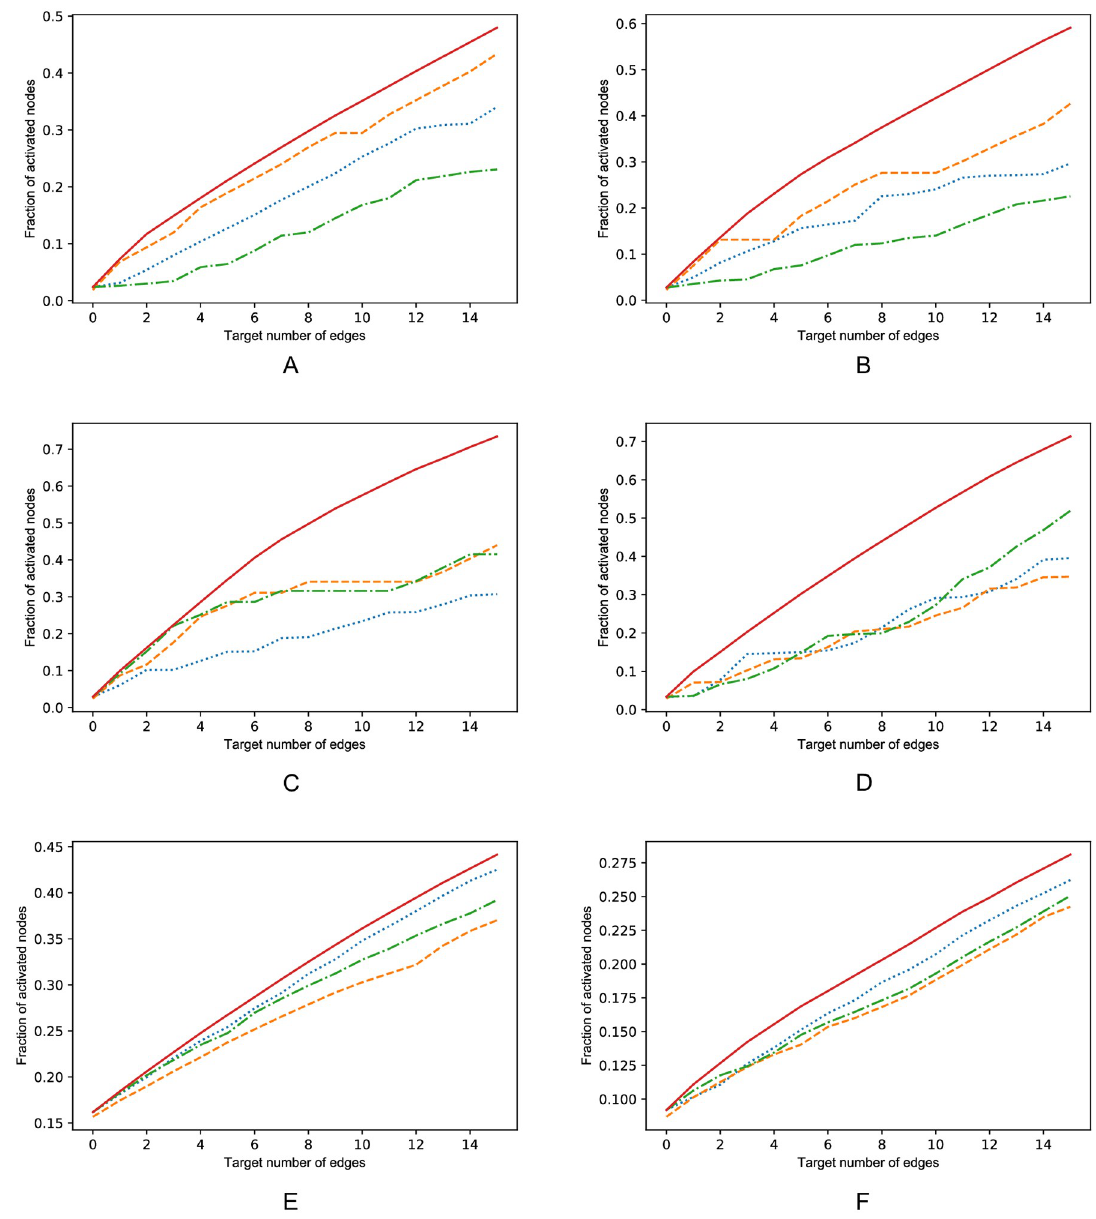
Fig 3. Performance of optimization algorithms in six different network types. On the x-axis the amount of selected edges is shown and on the y-axis the fraction of activated nodes. Network types are A: GN network. B: GNR network p = 0.3. C: GNC network. D: Random k = 5 network with 50 nodes. E: PL tree network. F: BA network m = 5. Legend: Solid red line: GLIM. Yellow dashed line: optimization using eigen vector centrality. Green dash-dotted line: optimization using outdegree. Blue dotted line: random edge